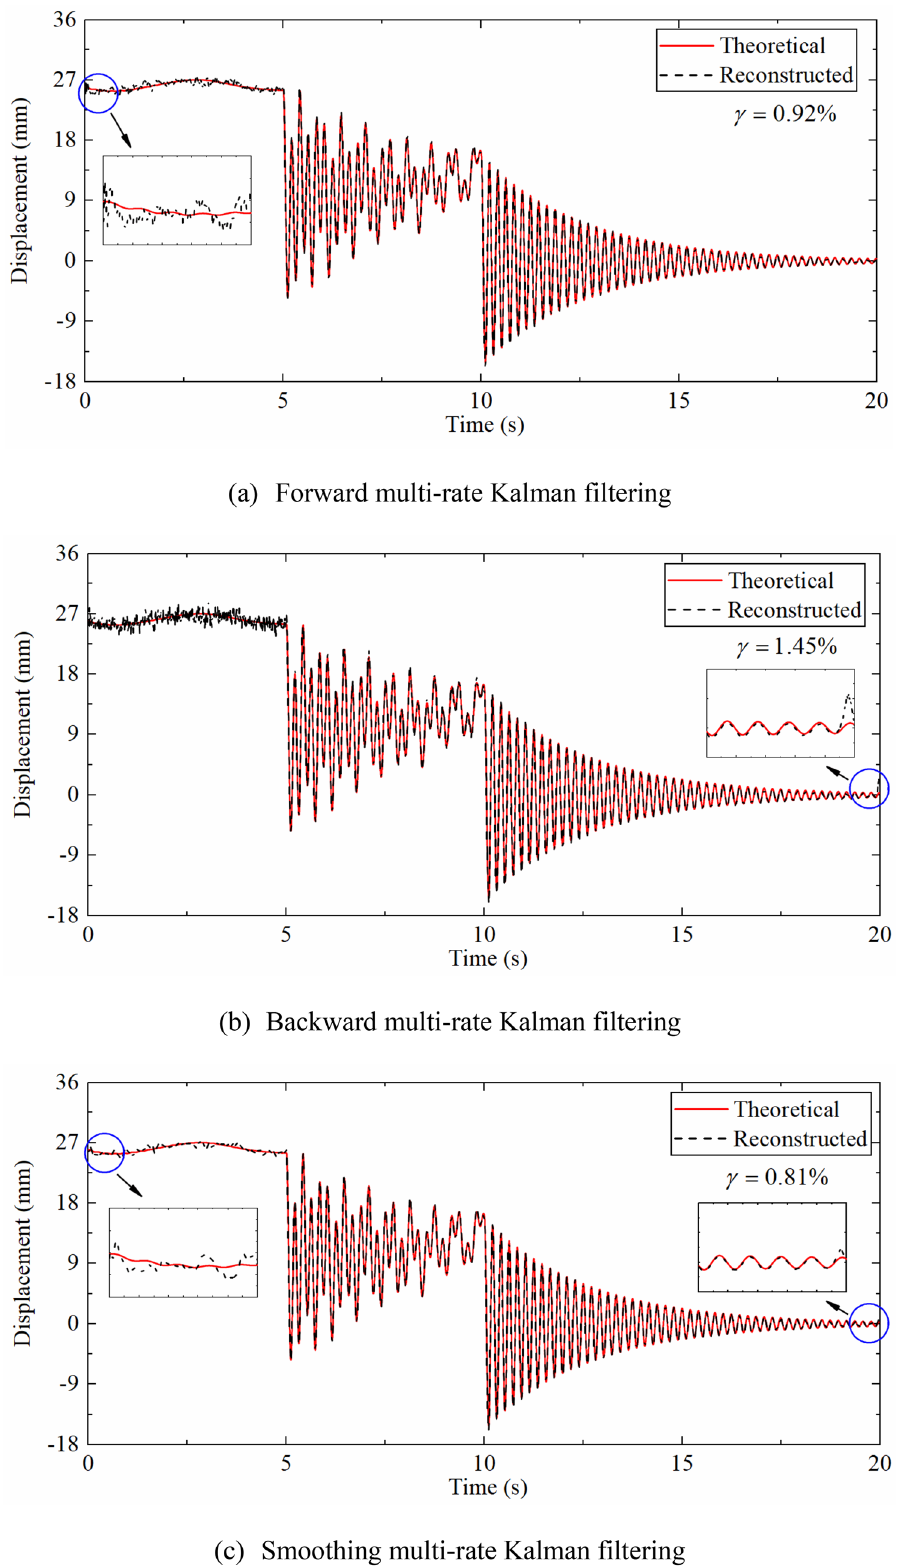
Figure 7. Displacement time histories reconstructed by different multi-rate Kalman filtering algorithms compared with theoretical